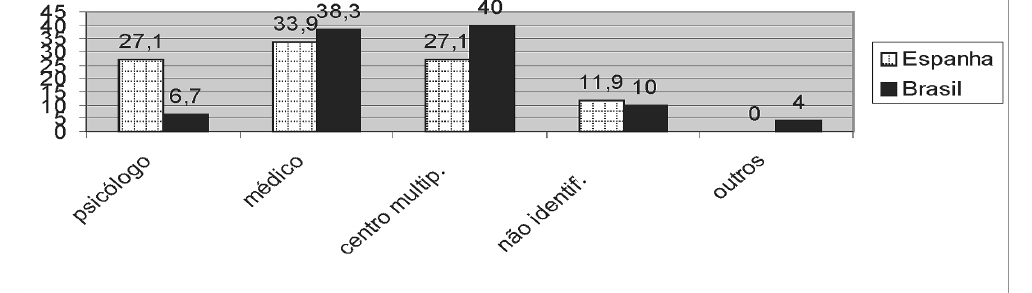
HIV/Aids.. Figura 2. Tipo de profissionais / pesquisadores que publicaram sobre Figura 4. Idioma das publica(cid:231)ıes sobre Figura 3. Pa(cid:237)s da revista em que os artigos sobre HIV/ Aids foram publicados. HIV/Aids.. Figura 5. Metodologia empregada nos estudos sobre